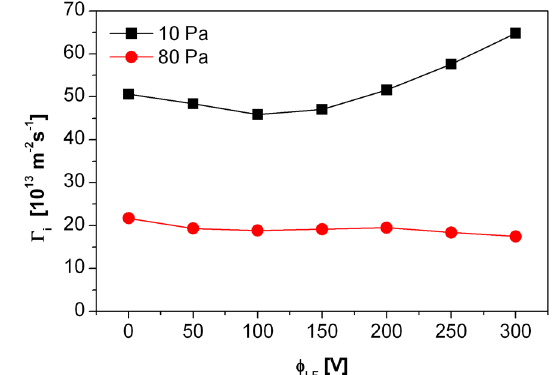
, at the electrodes in classical dual-frequency discharges as a function of i = 1.937 MHz, f = 27.12 MHz, Φ =300 V at 10 Pa and LF HF HF